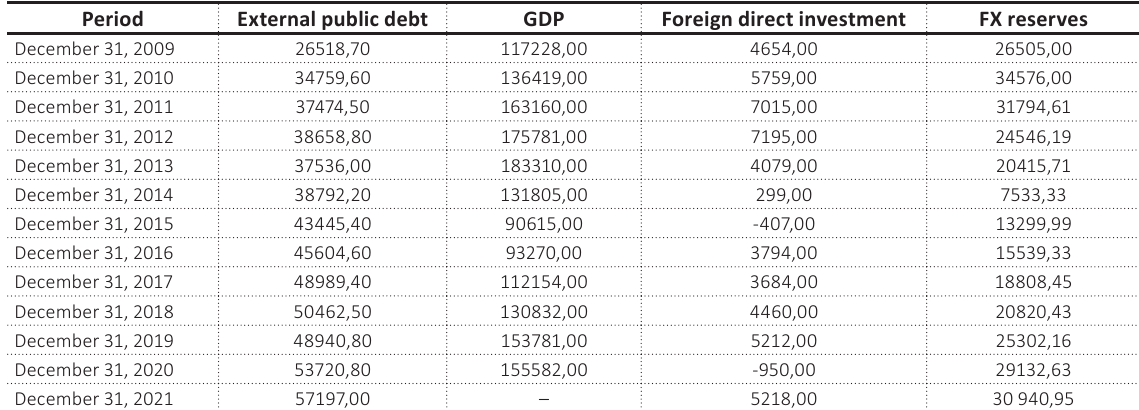
Table 1. Initial data for calculation for 2009–2021, USD mln Source: Built by the authors based on data from the Ministry of Finance of Ukraine. Period